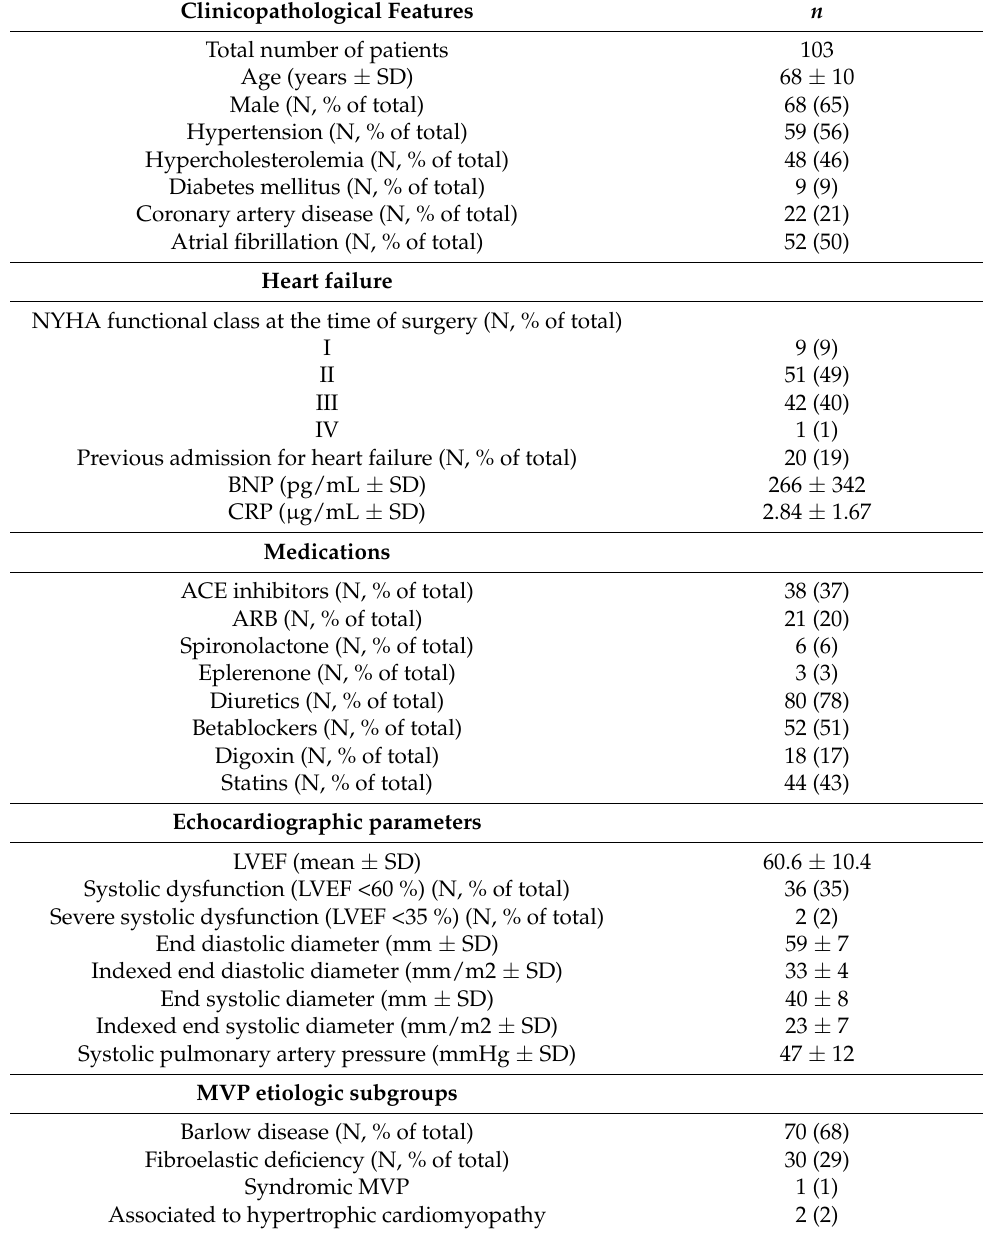
Table 1. Clinicopathological features of the patients with mitral valve disease (MVD). Values are N = number or mean ± SD. LVEF = left ventricular ejection fraction; NYHA = New York Heart Association classification of heart failure; BNP = brain natriuretic peptide; ACE = angiotensin converting enzyme; ARB = angiotensin receptor blockers; CRP = C reactive protein; MVP = mitral valve